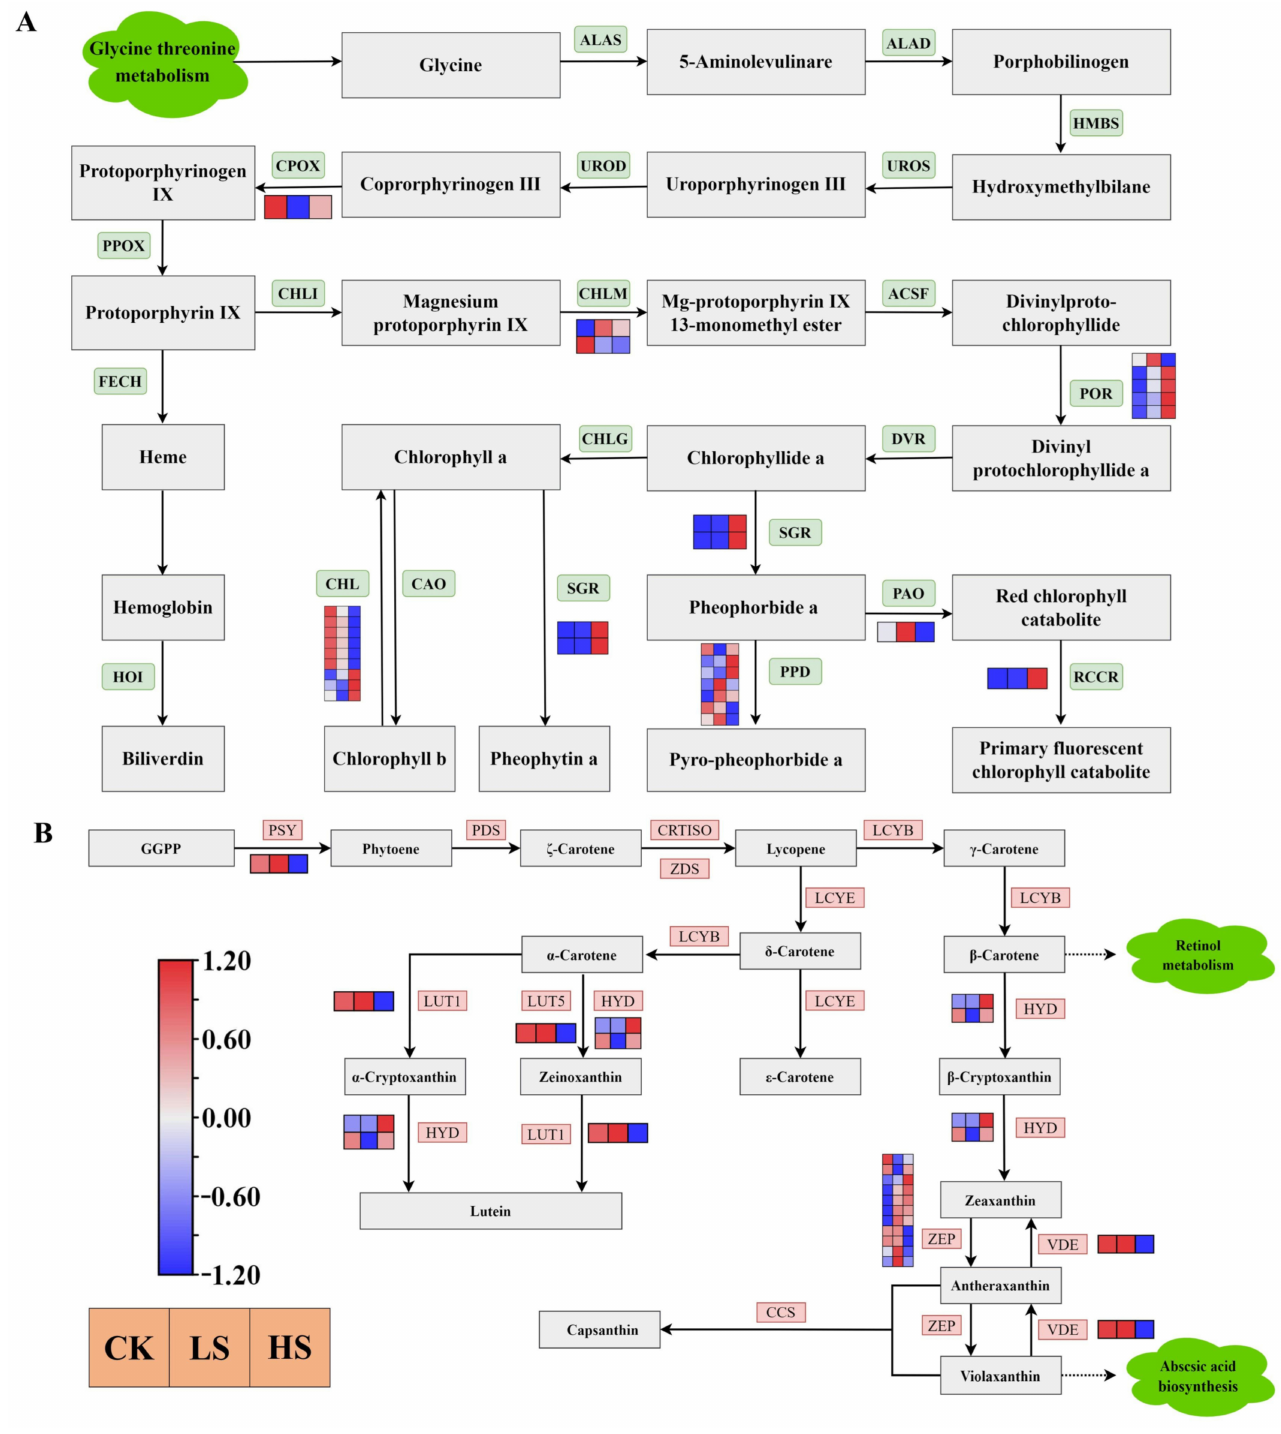
Figure 10. Transcriptional profiling of differentially expressed genes (DEGs) associated with pigment metabolism in P. koraiensis under light stress. ( A ) The DEGs involved in chlorophyll metabolism. ( B ) The DEGs involved in carotenoid biosynthesis. CK: control. LS: light shade. HS: heavy shade. The color scale from Min (blue) to Max (red) refers to the expression value from low to high. Carotenoids are essential for functional photosynthesis [45]. The results showed that a total 17 DEGs were annotated as key genes encoding enzymes related to carotenoid biosynthesis [46] (Figure 10B) (Supplementary Table S16). All DEGs of PSY, LUT1, LUT5 and VDE were downregulated in the shade treatment compared with the control. All